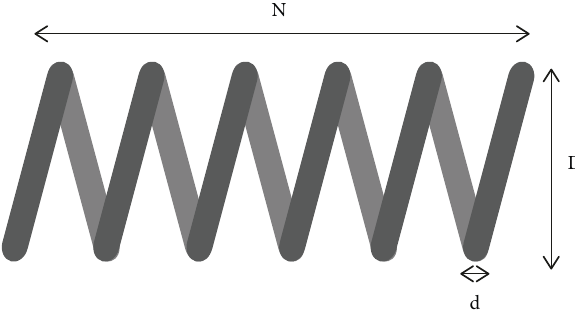
Figure 7: Design of tension/compression spring